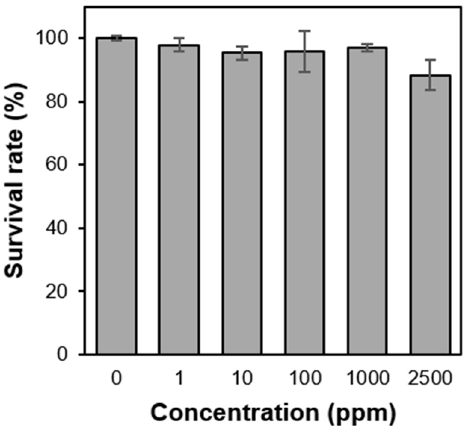
Figure 5. The cytotoxic effect toward 3T3 cells at different PS- b -PIN concentration.